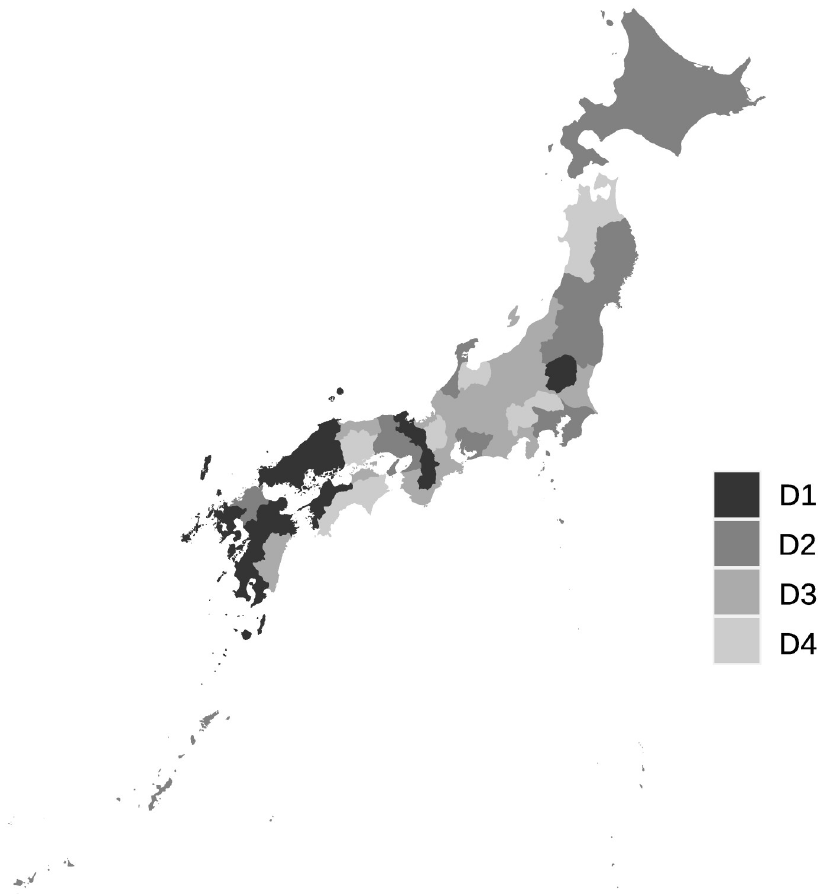
Fig 13. Prefectures belonging to clusters for domestic